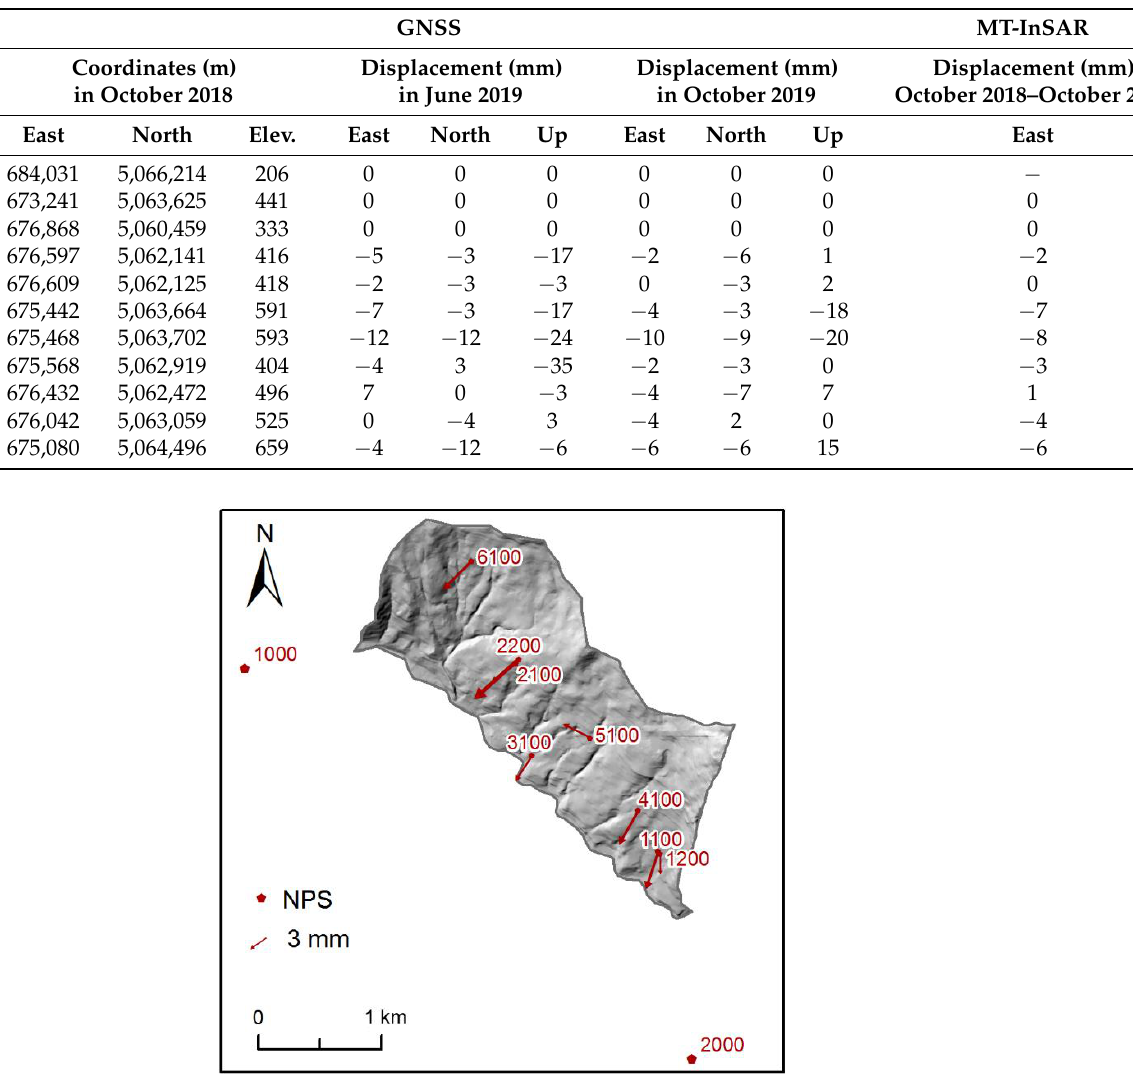
Table 1. Cumulative 3D displacements derived by GNSS survey and horizontal displacements measured by SBAS-InSAR in the period October 2018–October 2019. Points SCHI (Permanent Station), 1000 and 2000 are located outside the unstable slope to check the co-registration of the reference system for each survey.